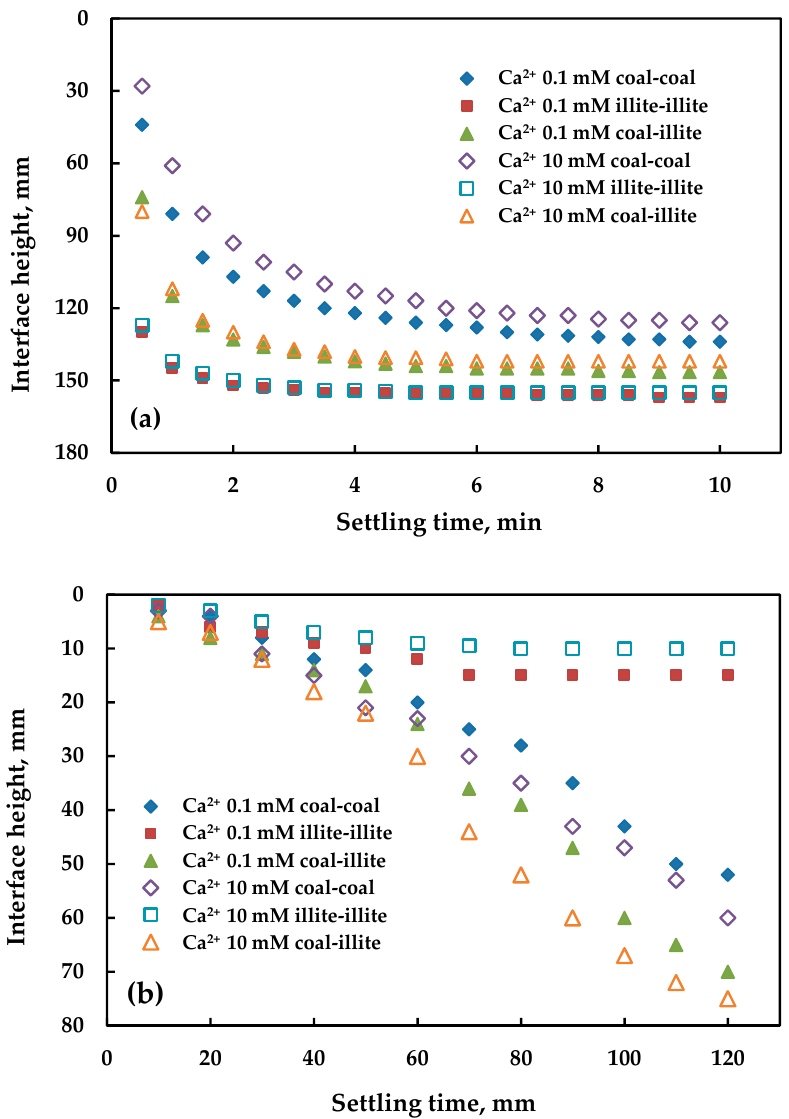
Figure 4. The sedimentation rate of particles when both calcium and PAM were added: ( a ) cationic PAM; ( b ) anionic PAM. The dosage of the two kinds of PAM was 4.5 mg/L.